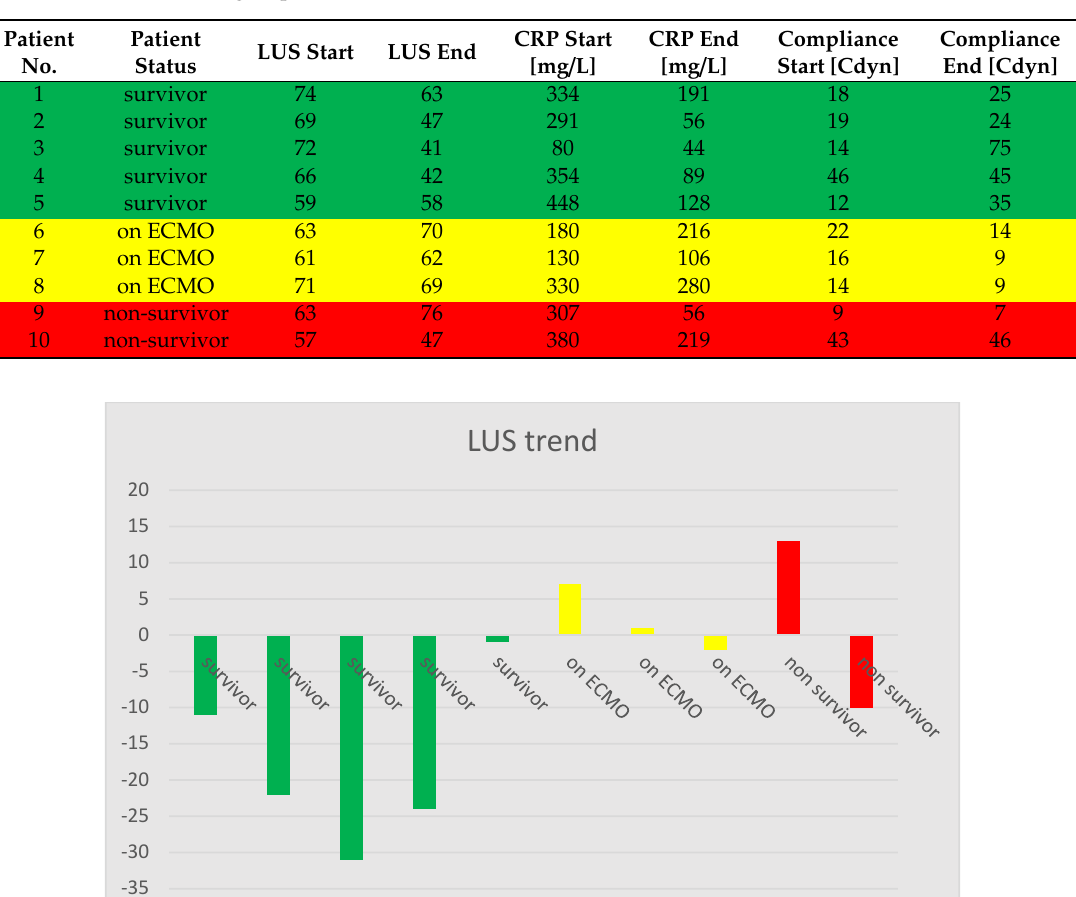
Table 3. Findings in 10 patients included. Start and end define first and last day of scan. End for “Survivor” group is before weaning from VV-ECMO, for “On ECMO” group at last day of study and for “Non-survivor” group before death.